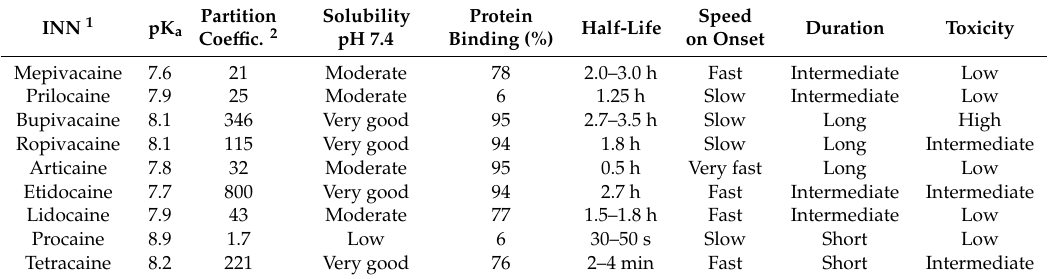
Table 1. Physical-chemical / pharmacokinetic properties and toxicity of some local anesthetics. Partition INN 1 pK a Coe ffi c. 2 Etidocaine